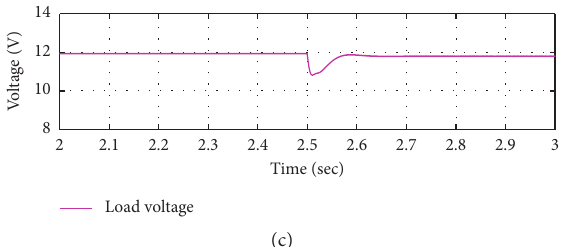
Figure 9: Simulation results for an increase in the load. (a) The output voltage of converter I. (b) The output voltage of converter II. (c) The voltage at the common DC